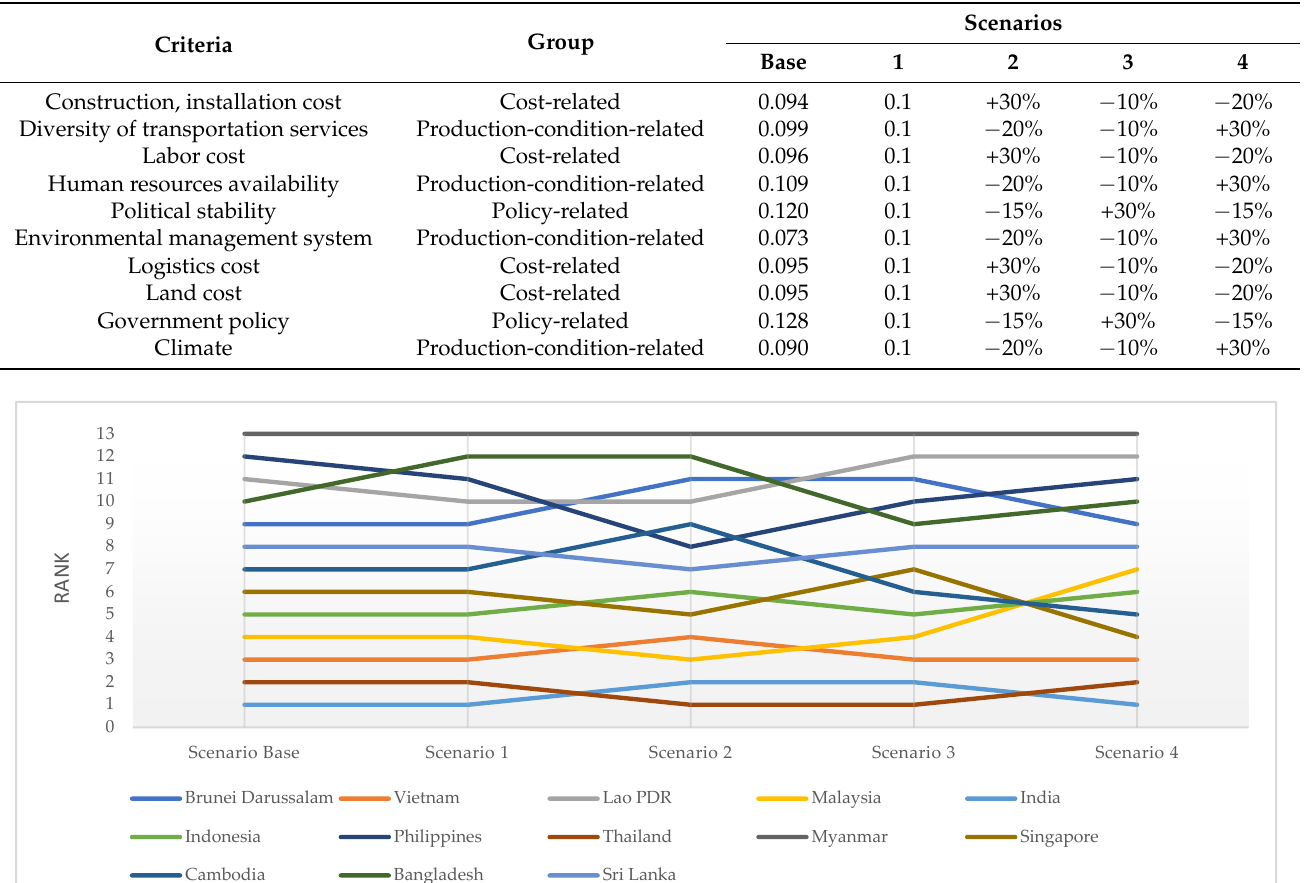
Figure 8. Risk-aversion coefficient sensitivity analysis. For the regret-aversion coefficient, the sensitivity analysis shows that this coefficient can create a large disturbance in the results of the proposed method. As shown in Figure 9,